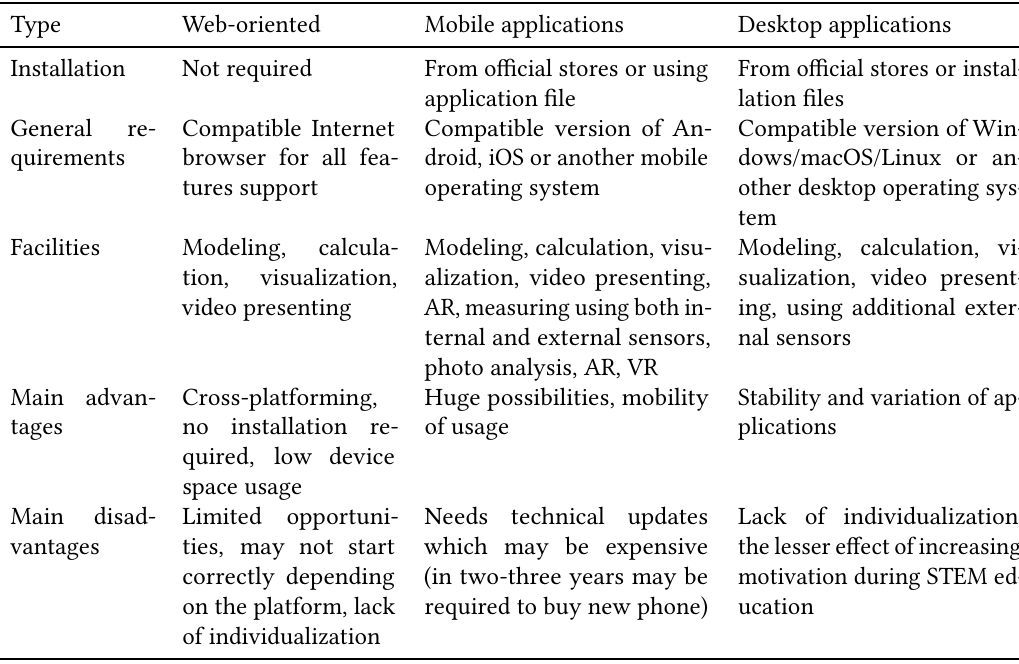
Comparison of the most used in the education process